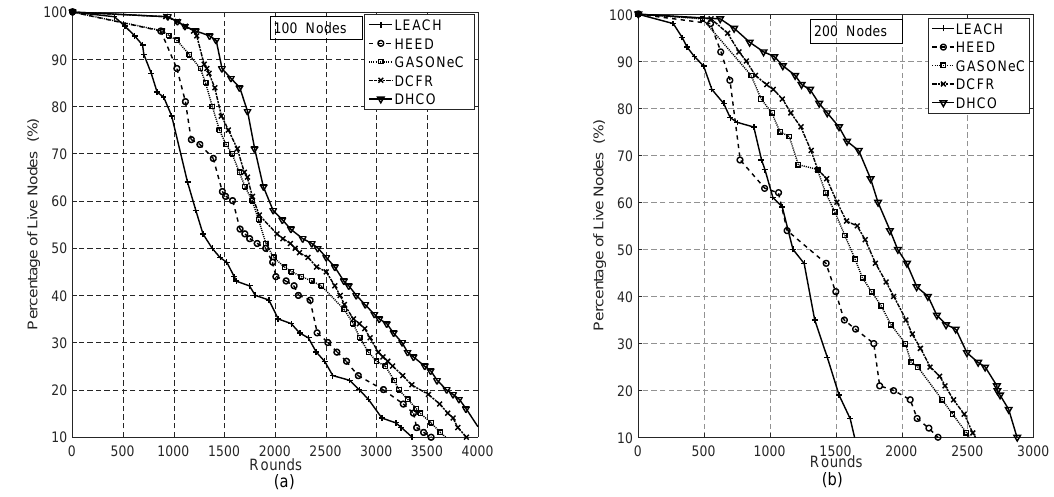
Figure 4. Percentage of live sensor nodes with sensor nodes of a random distribution for various algorithms in the deployment scenario of a 100 m × 100 m square region and the coordinate (50, 50) of the BS: ( a ) 100 sensor nodes of a random distribution, and ( b ) 200 sensor nodes of a random distribution. 5.3. Wireless Sensor Network Longevity versus the Width of the Sensing Field and the Number of Sensor Nodes The number of sensor nodes and the width of the sensing field are critical factors influencing the energy consumption of sensor nodes and the WSN longevity. For diverse widths of the sensing fields